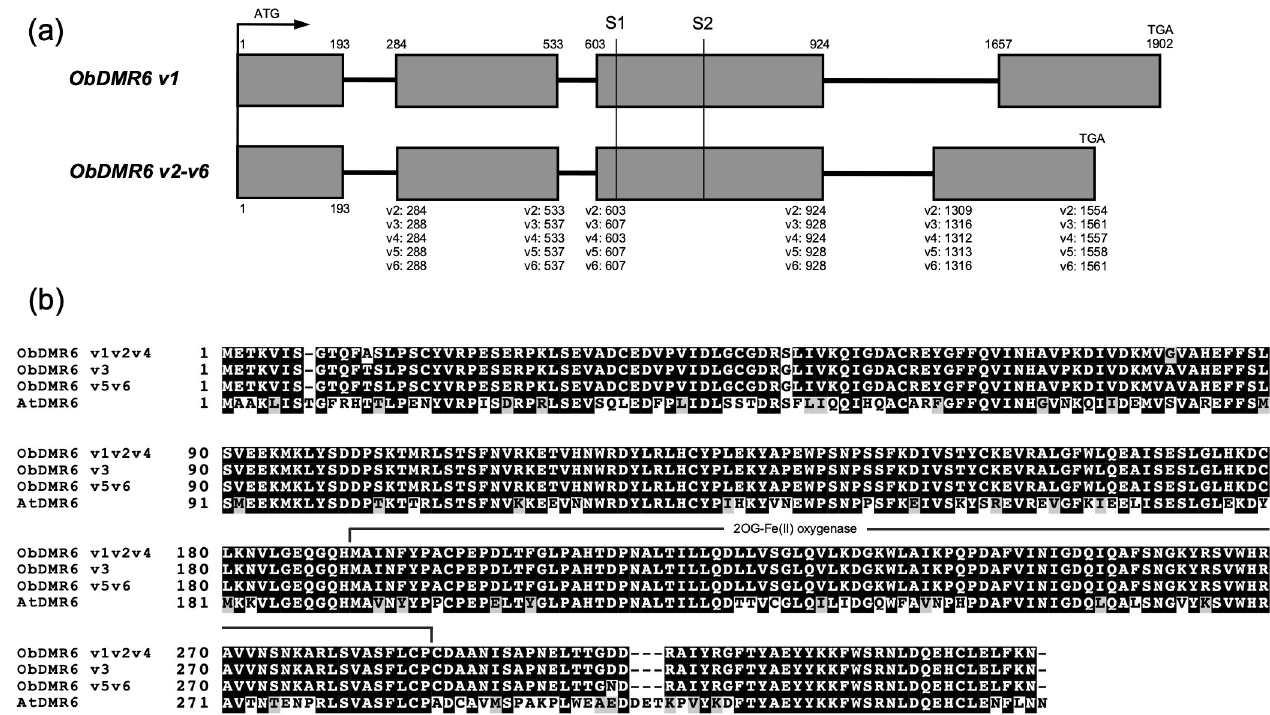
Fig 1. Schematic diagrams of gene structure of ObDMR6 variants and their amino acid sequence alignment with AtDMR6. (a) Exons and introns of six ObDMR 6 variants (v1-v6) starting from the start codon (ATG) to stop codon (TGA). Exons and introns are indicated using shaded boxes and solid lines, respectively. The numbers represent the nucleotide positions starting from the start codon. The positions of two sgRNA target sites (S1 and S2) are indicated. (b) Alignment of three distinct amino acid sequences of six ObDMR6 variants with AtDMR6. The conserved domain that defines 2OG-Fe(II) oxygenase superfamily of oxidoreductase (pfam03171) is indicated.